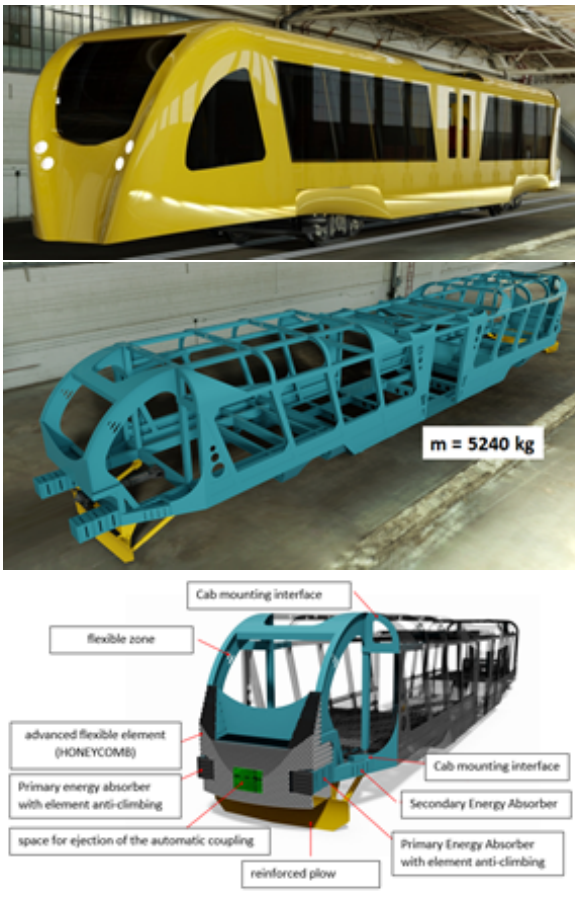
Figure 7. Design study of the Rail – electric bus